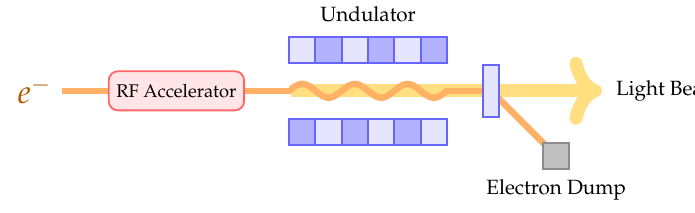
Figure 1. Conceptual schematic of an accelerator driven light source.